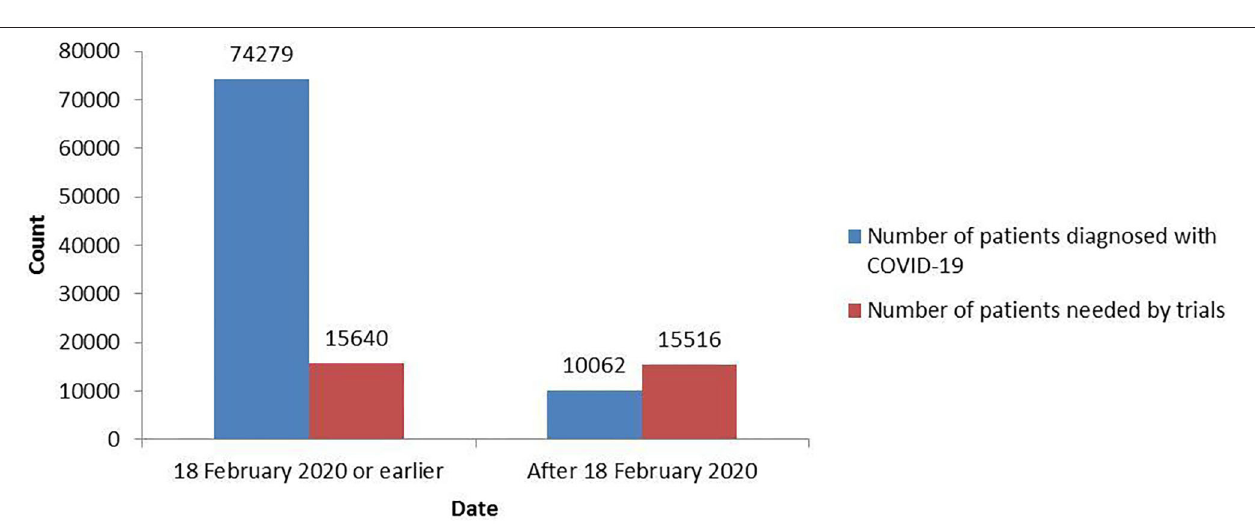
FIGURE 1 | The timeline of new sample size needed by the trials and the new cases with COVID-19.